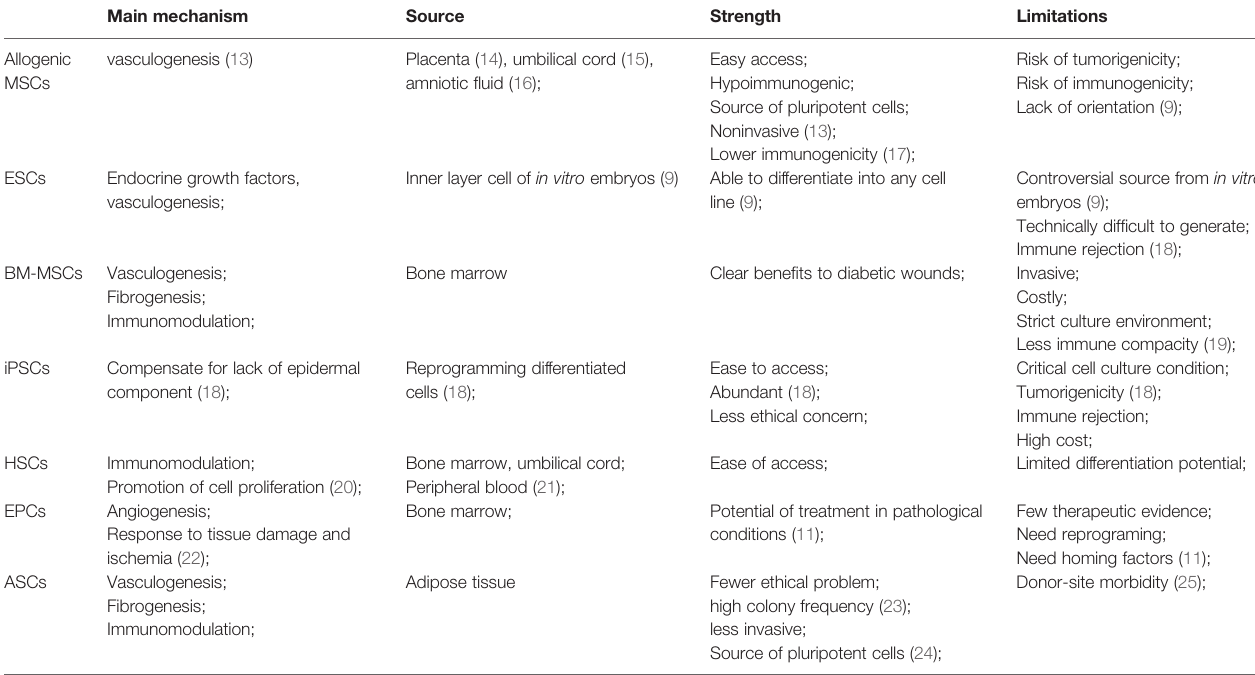
TABLE 1 | A brief comparison of characteristics of different types of stem